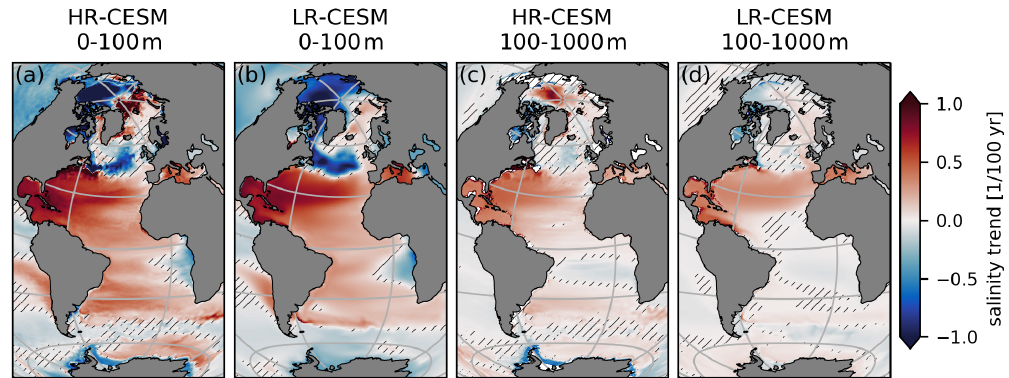
Figure 8. Linear trends of the vertically averaged salinity in the surface (0–100m) and subsurface (100–1000m) layers under the RCP scenario. Areas where the linear trend is not significant at the 5% level are